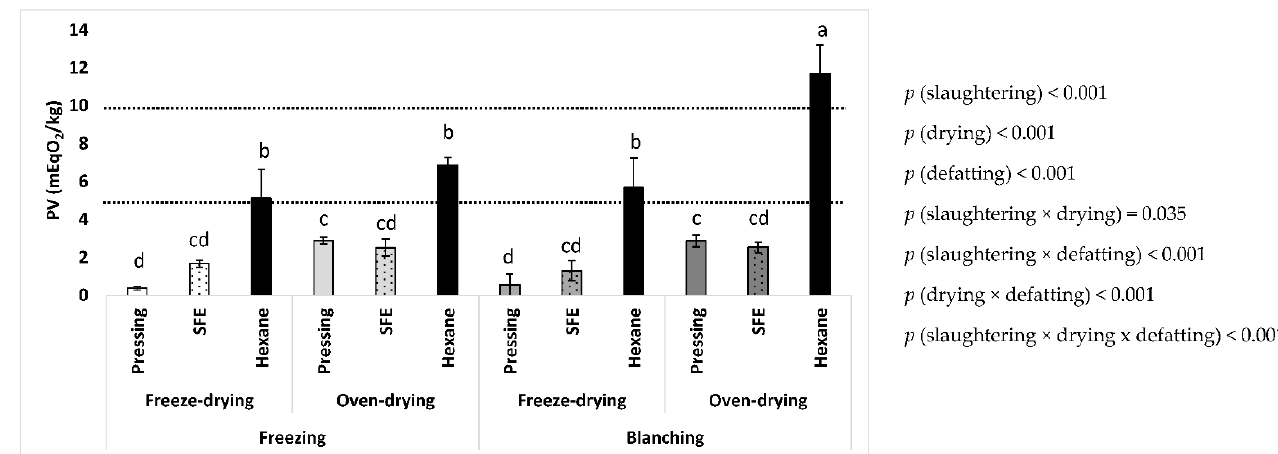
Figure 1. Initial oxidative state (PV) of the fat from BSFL processed by different methods of slaughtering, drying, and defatting. Dotted line means maximum reference values. Different letters between the treatments mean significant differences. Each data point corresponds to mean values ± SD, n = 4.